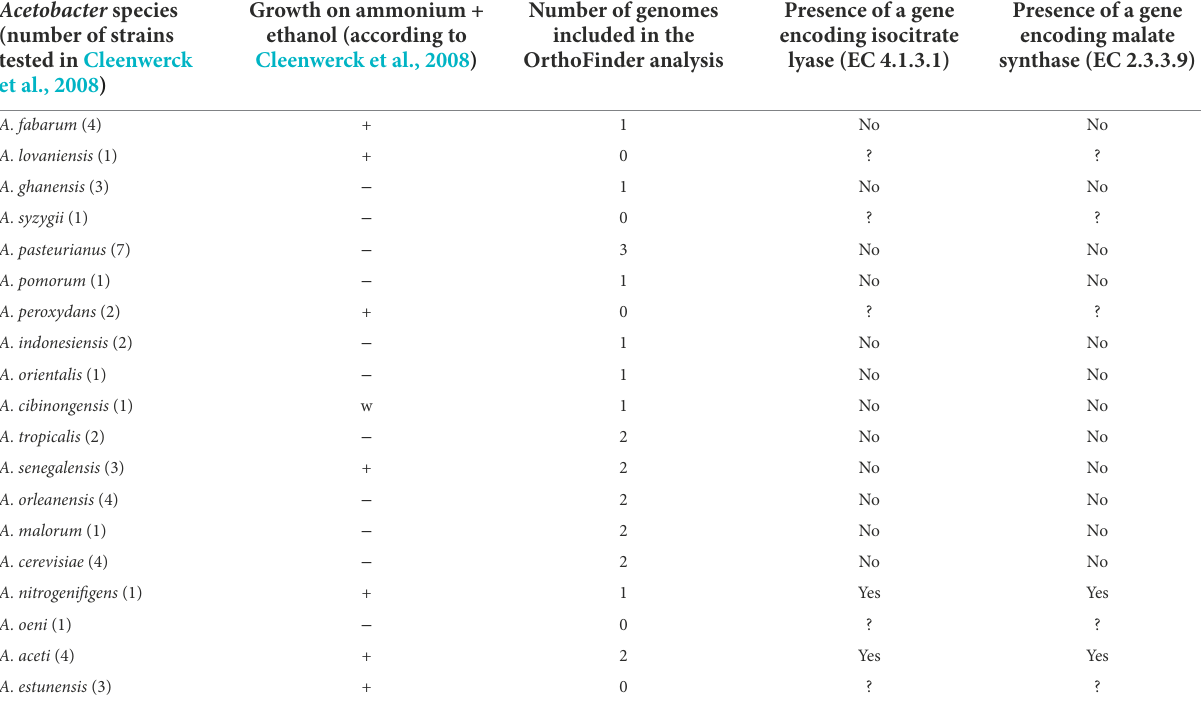
TABLE 4 Overview of the presence of the glyoxylate cycle enzymes in genomes of strains of Acetobacter species. Acetobacter species (number of strains tested in Cleenwerck et al.,